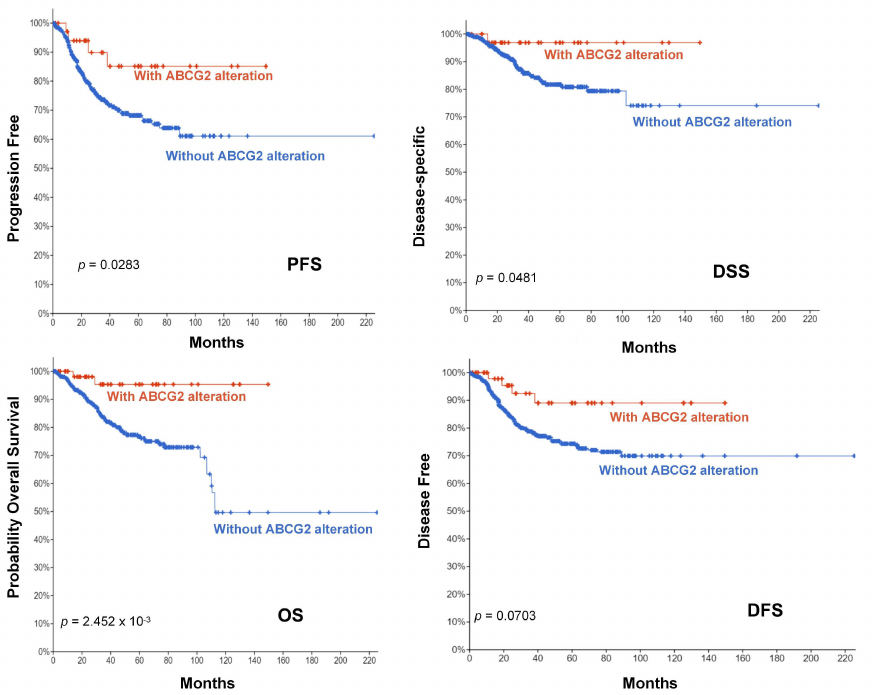
Figure 8. The potential correlation between the mutation site and the survival patterns. The potential correlation between this mutation site and progression-free survival (PFS) (n = 528), overall survival (OS) (n = 1602), disease-specific survival (DSS) (n = 526), and disease-free survival (DFS) (n = 1346) of UCEC is